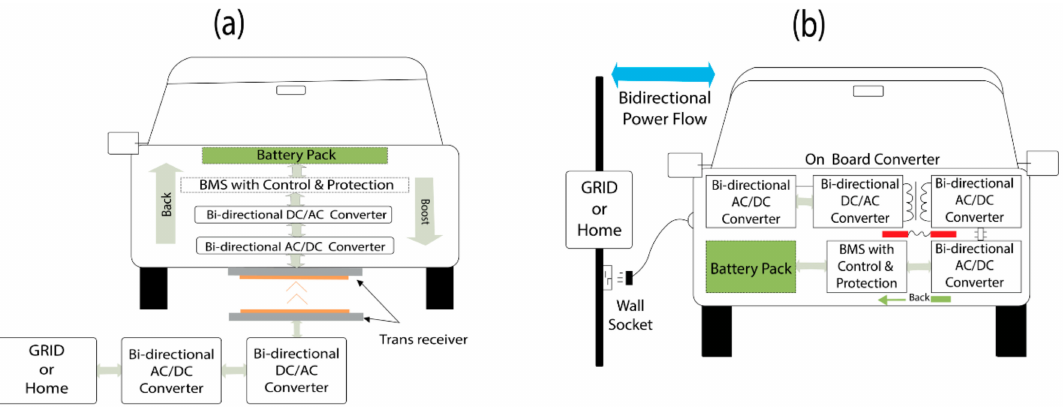
Figure 5. ( a ) Inductive and ( b ) conductive charging. Adapted from source